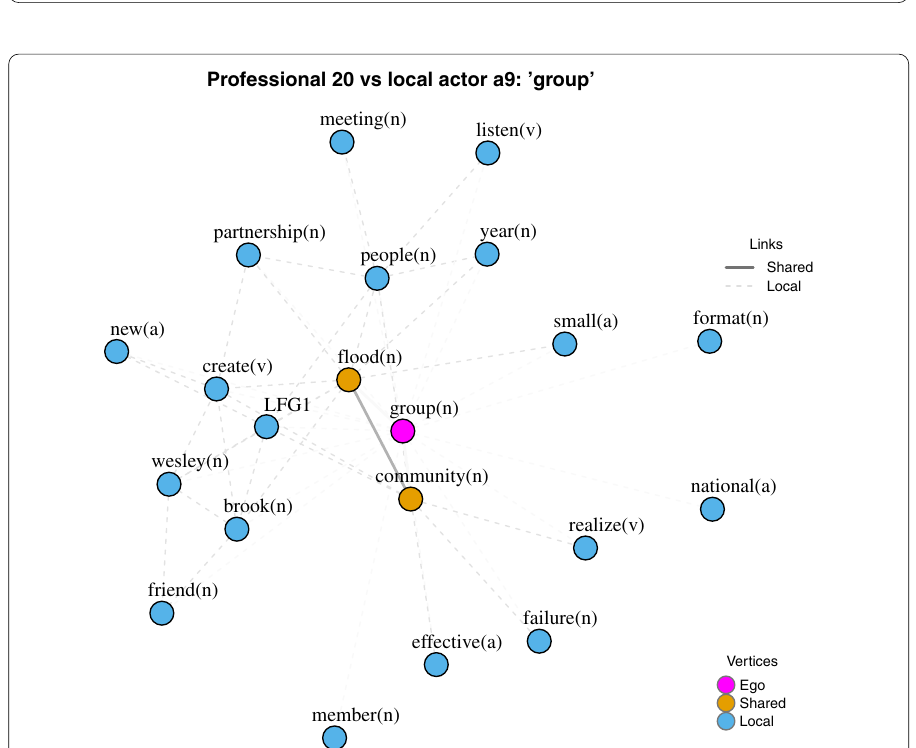
Fig. 9 The professional network is based on threshold value 25. For display purposes, only shared and local-specific concepts are